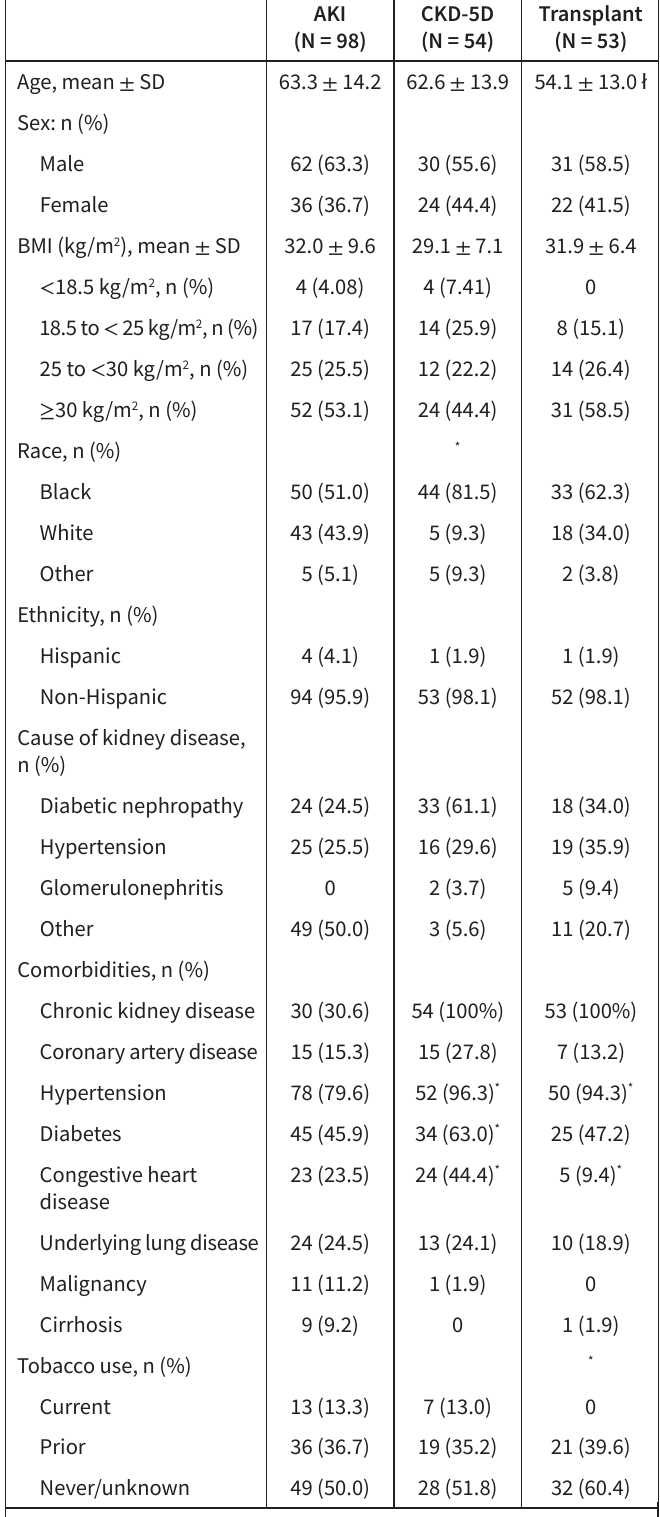
Table 1. Demographic and Comorbidity Profiles of the Study